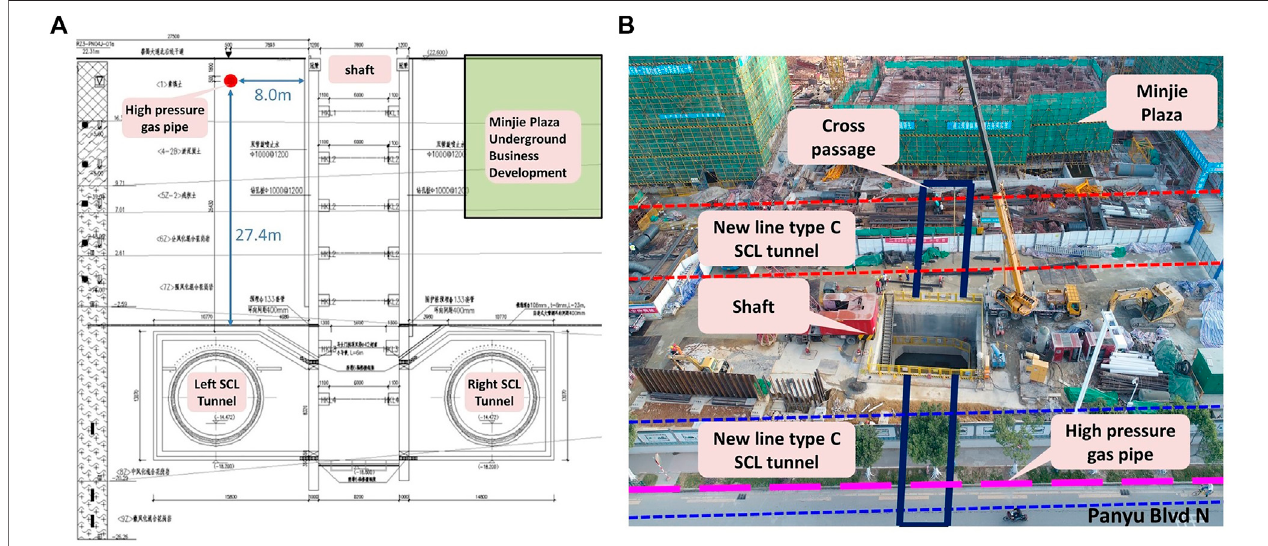
FIGURE 5 | Relative location of the high-pressure gas pipe and tunnel construction: (A) drawing section; (B) construction site bird view.